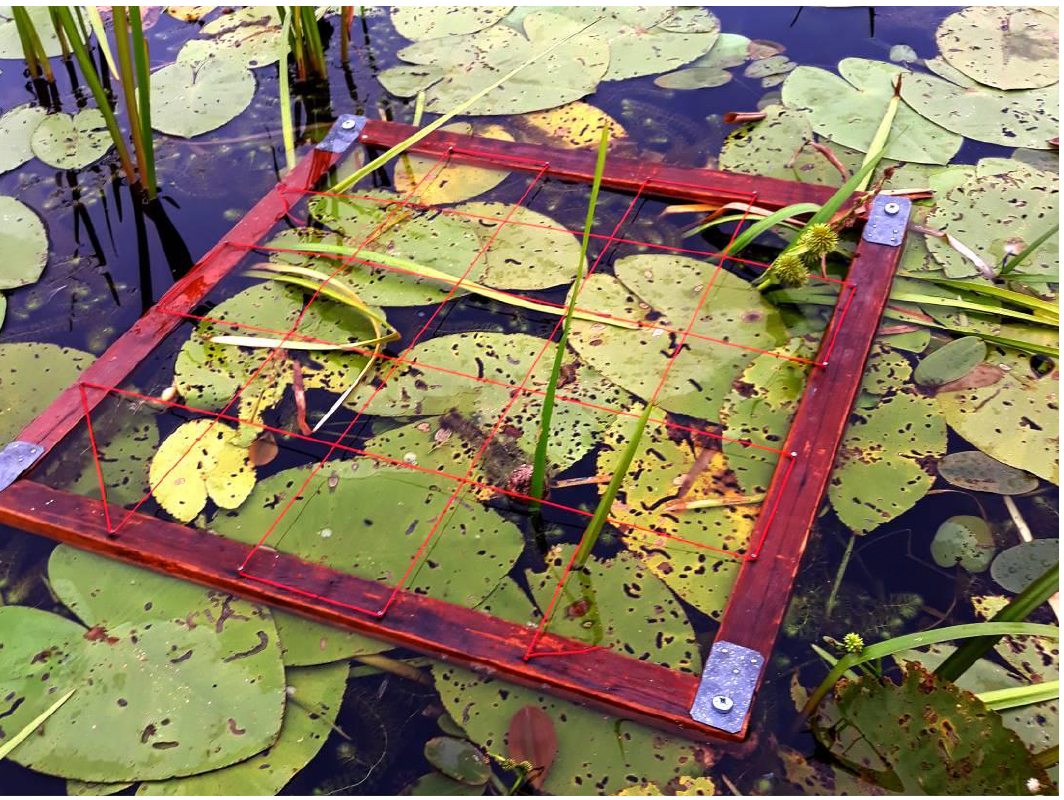
Figure 2. Sampling plot was delimited by a graded wooden frame to study Aldrovanda vesiculosa populations (photo by Z. Sinkevičienė).